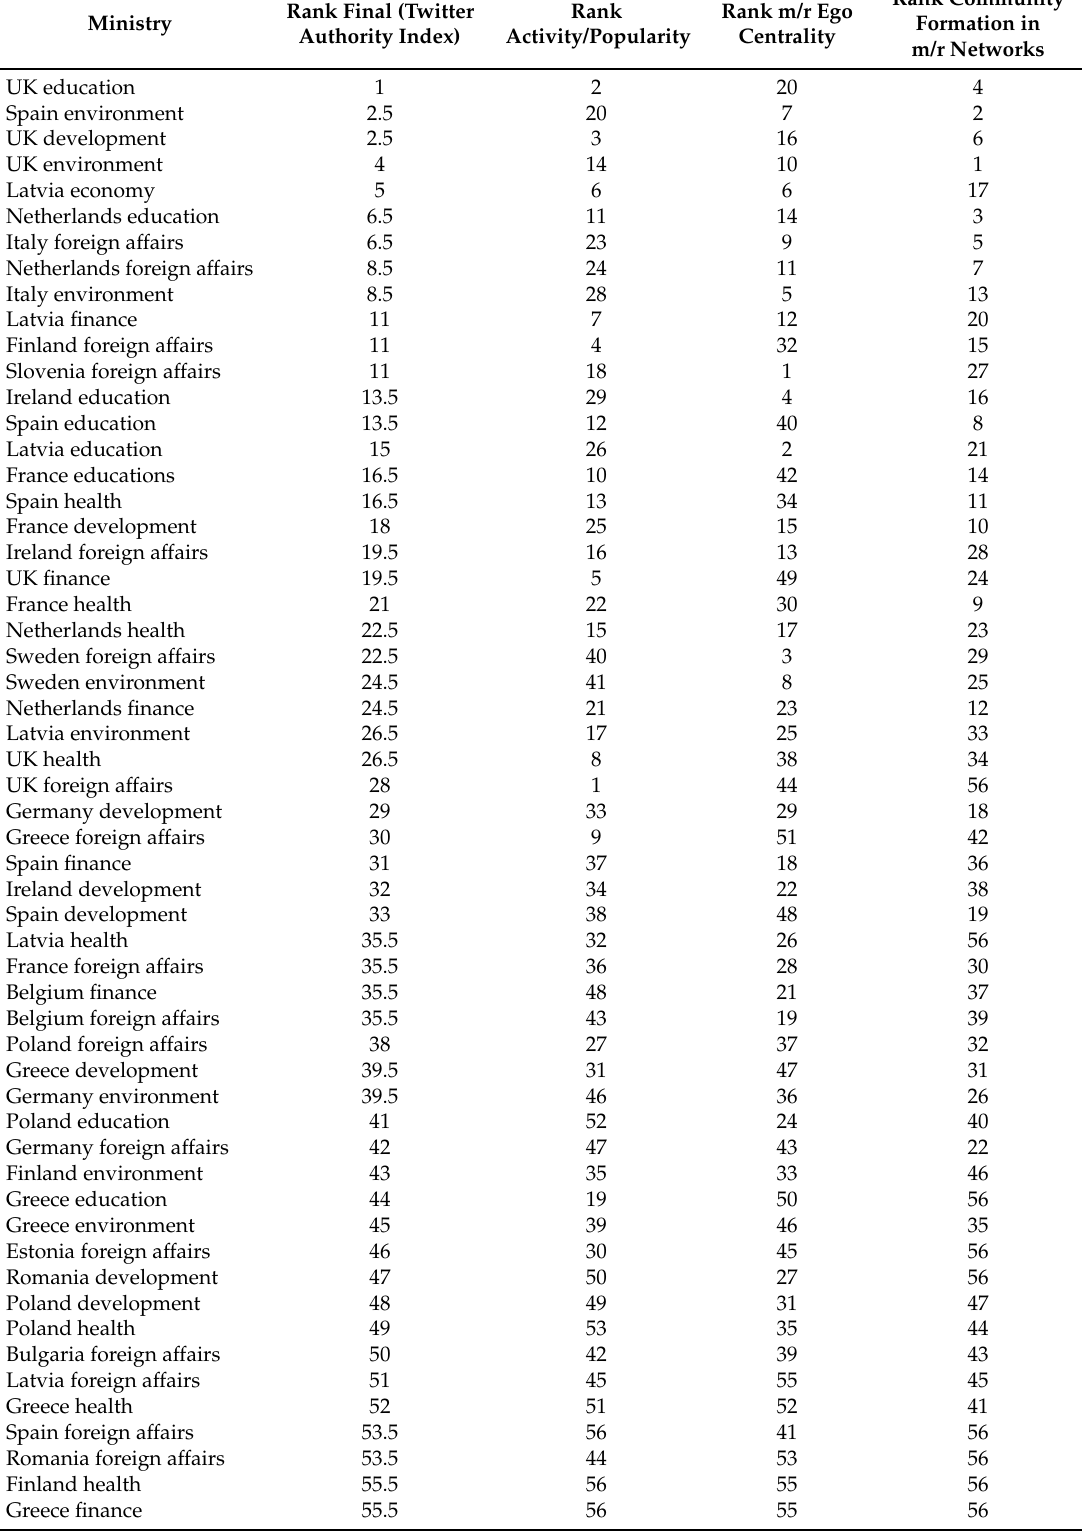
Table 4. Ranks of the 56 EU ministries Twitter